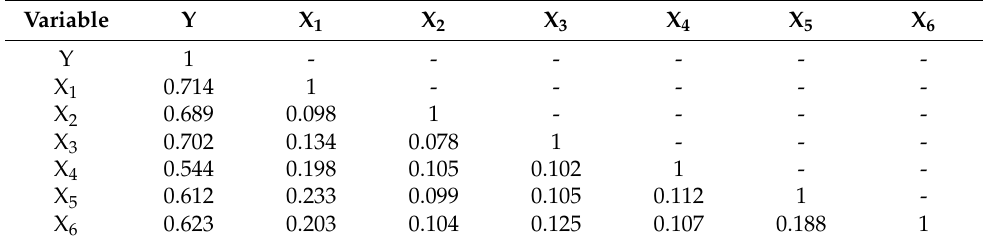
Table 4. The Correlation